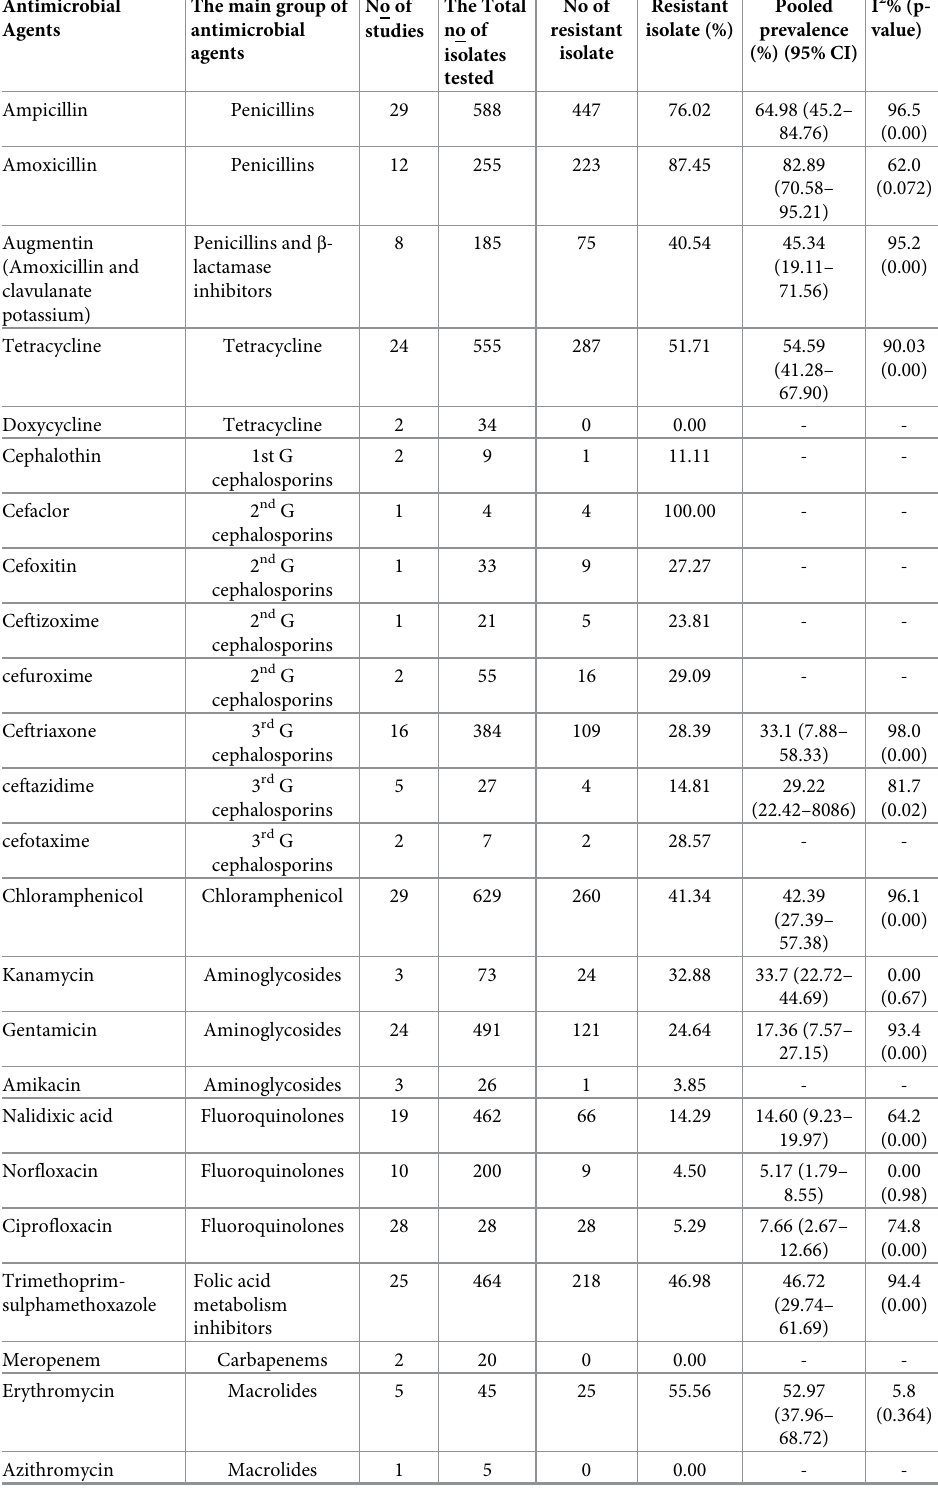
Table 6. The pooled prevalence of Salmonella enterica resistance to different antimicrobial agents in Ethiopia. Antimicrobial